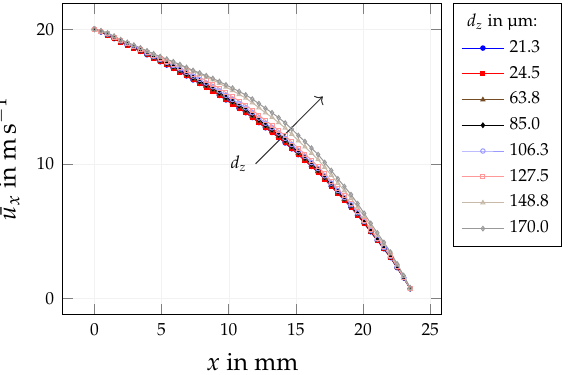
Figure 23. Velocity profiles ¯ u x ( x ) in inlet channel